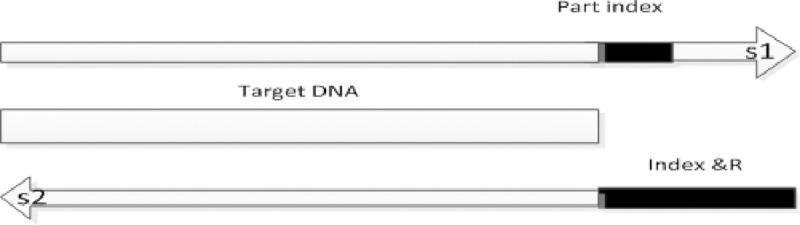
Bidirectional sequence in the index part of the sequence.